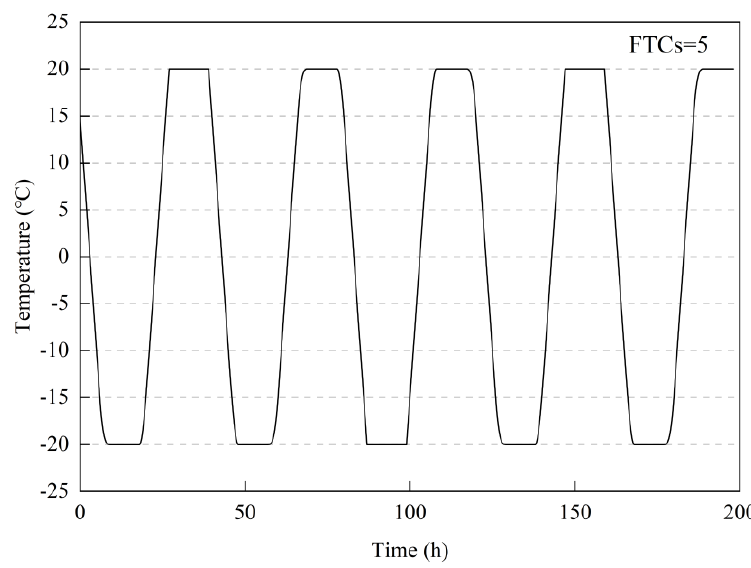
Figure 4. Variation of the specimen temperature with time during FTC.